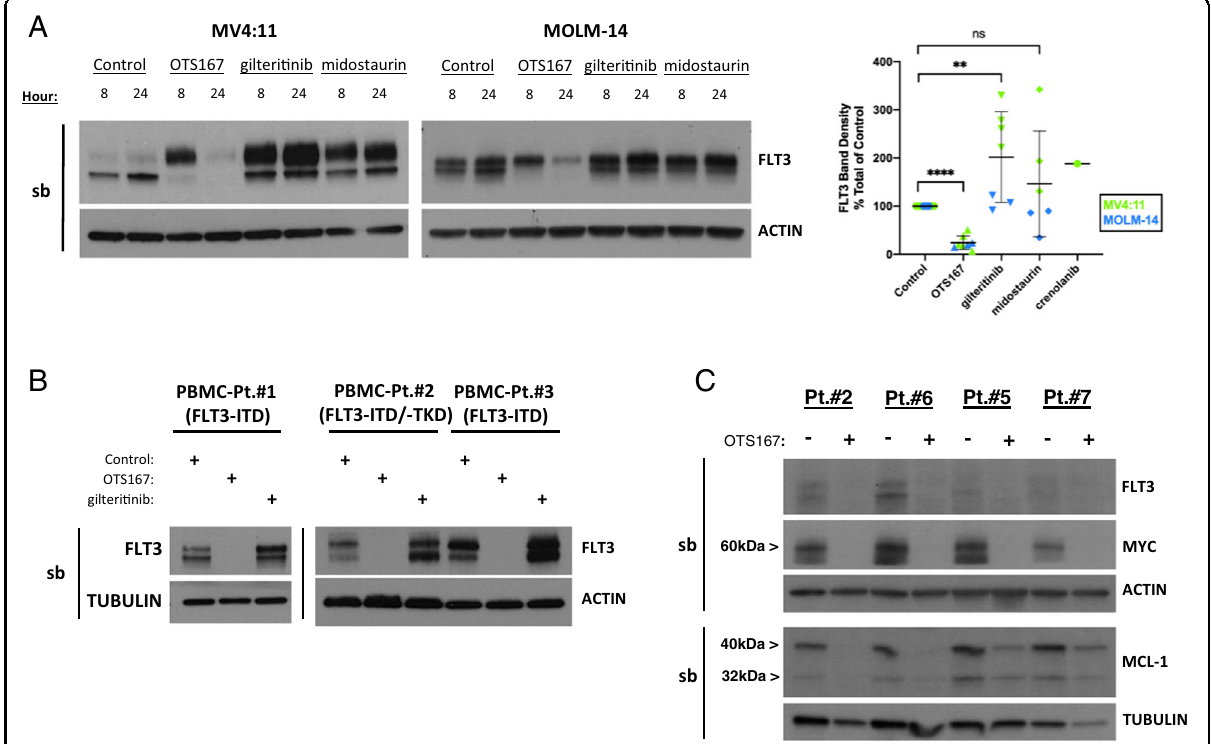
Fig. 1 OTS167 downregulates FLT3-ITD expression in FLT3 mutant cell lines and primary patient cells. A Western blot analysis of FLT3 expression in MV4:11 or MOLM-14 after treatment with 50 nM OTS167, 50 nM gilteritinib, or 50 nM midostaurin for 8 or 24 h. (single blot (sb)) Graph of seven biological replicates shows densities of both FLT3 bands together at 24 h as a percent total of control. (In graph, 50 nM crenolanib was also used to treat MV4:11). B Western blot analysis of FLT3 expression in FLT3 mutant primary patient mononuclear cells after treatment with 50 nM OTS167 or 50 nM gilteritinib for 24 h. (1 biological replicate per patient)(single blot). C Western blot analysis of oncoprotein expression in FLT3 mutant primary patient mononuclear cells after treatment with 50 nM OTS167 for 24 h. (1 biological replicate per patient)(single blots as indicated) (**** P < 0.0001, ** P < 0.01, ns-not signi fi